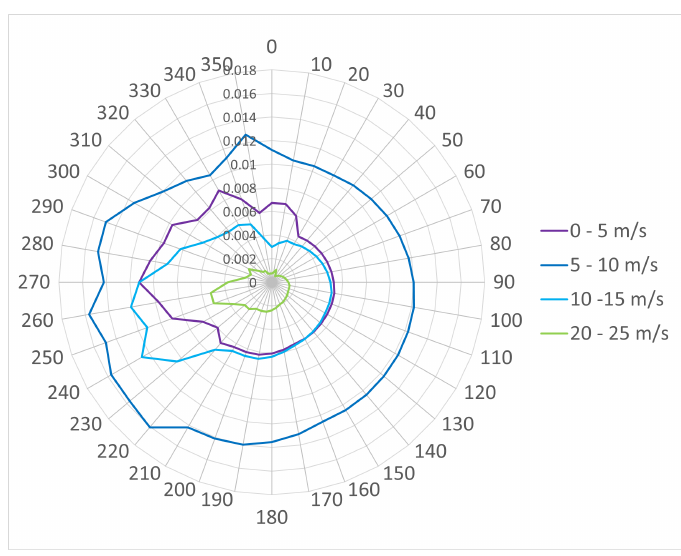
Figure A6. Wind Rose B – with prevailing wind